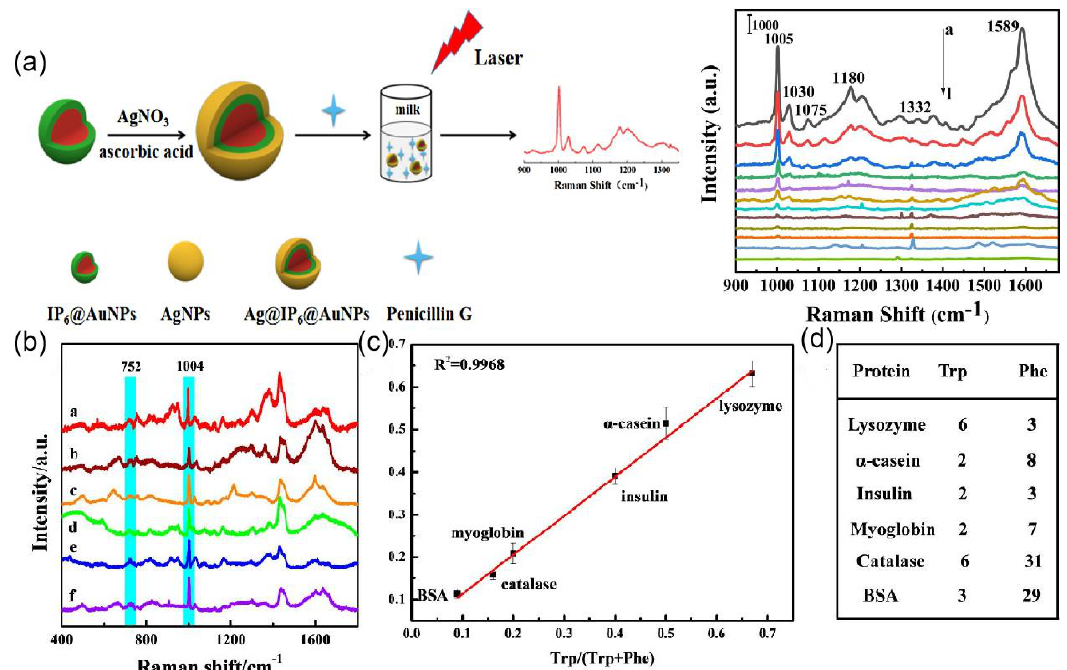
Figure 16. ( a ) Schematic fabrication process of Ag@IP6@AuNPs substrate and the SERS detection of PG. Concentration-dependent SERS spectra of Penicillin G by using Ag@IP6@AuNPs. Reprinted